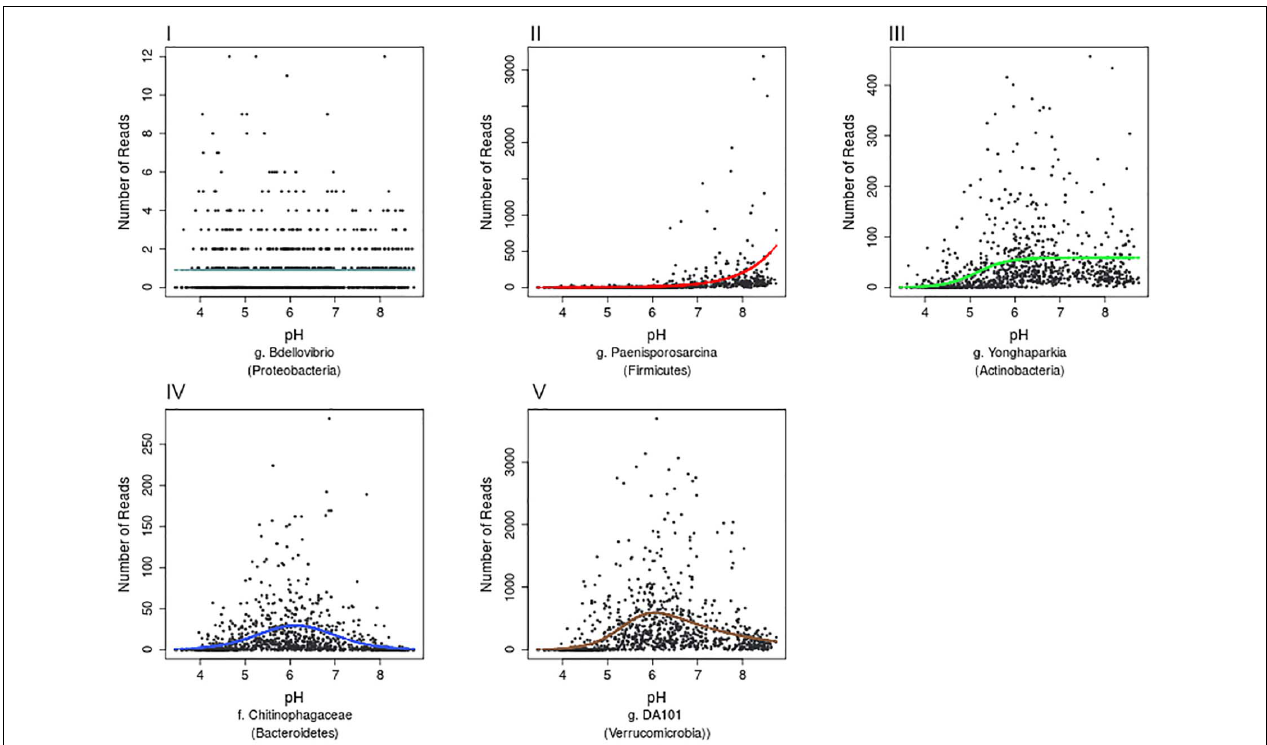
FIGURE 3 | Examples of the five HOF model types. HOF models were generated through fitting countryside survey OTU abundances to soil pH (a pH range from 3.63 to 8.75). The five HOF models used were: (I) no change in abundance across pH gradient, (II) montonic an increase or decrease in abundance along pH gradient, (III) plateau an increase or decrease in abundance along pH gradient that plateaus, (IV) symmetrical unimodal, abundance increases and decreases across gradient at an equal rate, (V) skewed unimodal, abundance increases and decreases across gradient at unequal rates.